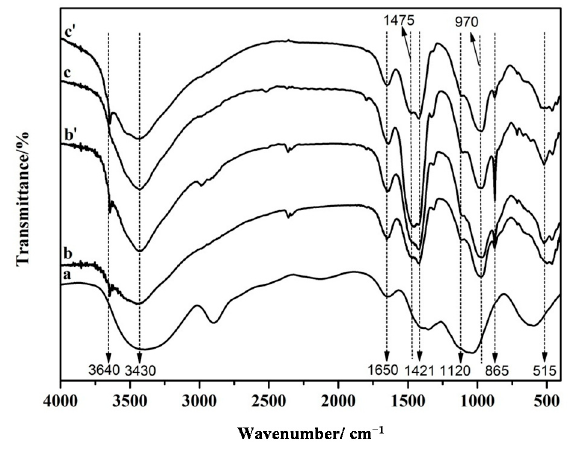
Figure 5. FT-IR spectra of (a) SMC, (b) cement paste at 3 days, (b ′ ) cement paste at 28 days, (c) cement paste with SMC at 3 days, and (c ′ ) cement paste with SMC at 28 days.